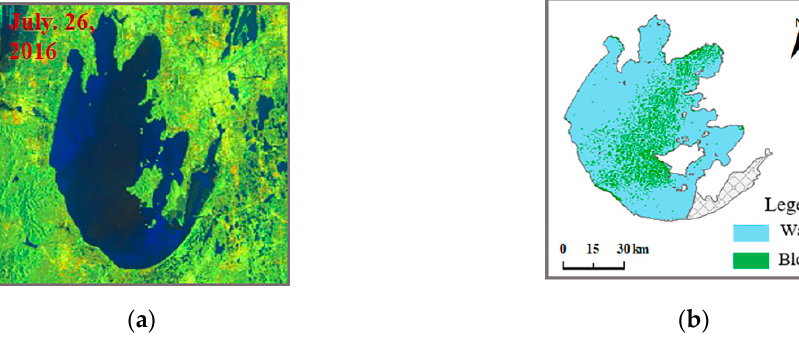
Figure 7. Example of algal bloom extraction in a SAR image. ( a ) Sentinel-1 image acquired on 26 July 2016. ( b ) The spatial distribution of the algal bloom obtained by the Wishart classifier.